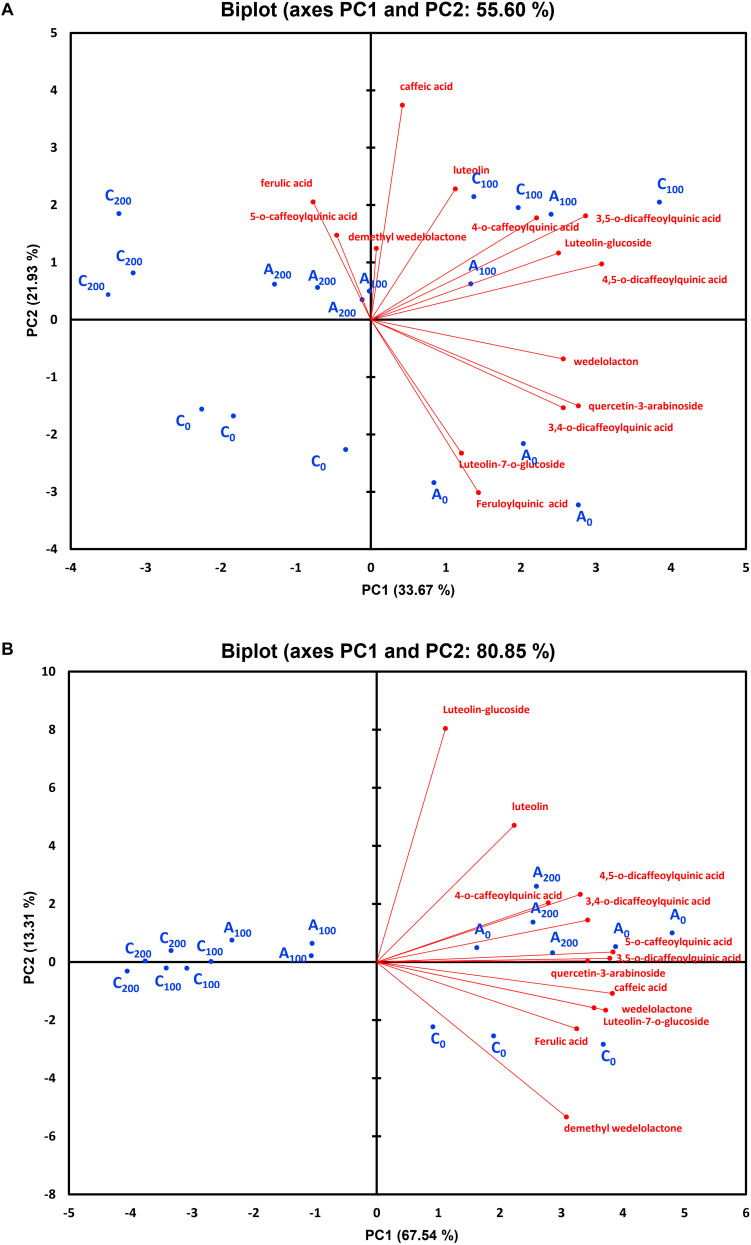
Principal component analysis of individual polyphenols in the leaves of Eclipta prostrata inoculated with arbuscular mycorrhiza or not inoculated under non-stress, saline conditions 4 (A) and 8 weeks (B) after inoculation. C0, control treatment (plants without mycorrhiza) under non-saline conditions; C100, control treatment exposed to 100 mM NaCl; C200, control treatment exposed to 200 mM NaCl; A0, mycorrhizal treatment under non-saline conditions; A100, mycorrhizal treatment exposed to 100 mM NaCl; A200, mycorrhizal treatment exposed to 200 mM NaCl.